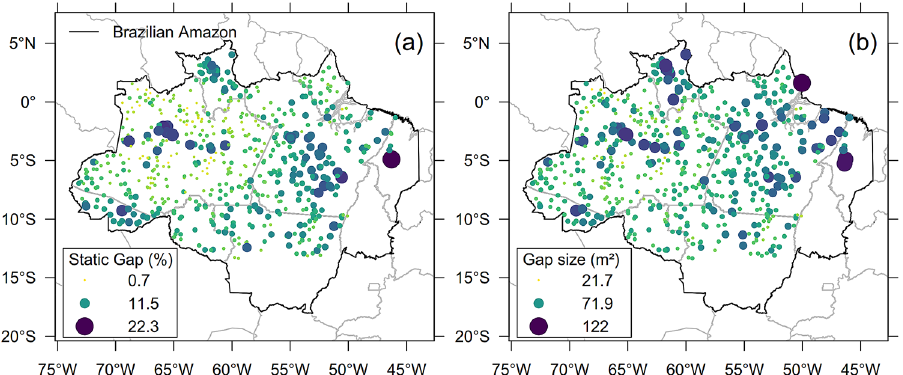
Figure 3. Canopy gaps based on the relative height ( RH = 50, W = 5) across the Brazilian Amazon ( n = 610 flight lines). ( a ) Gap fraction (%). ( b ) Mean gap size (m 2